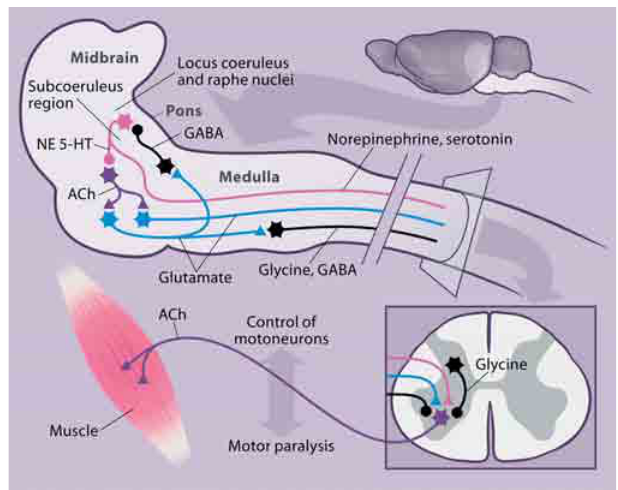
Figure 1. Model of Some of the Major Systems Involved in Regulating Muscle Activity in REM Sleep Drawn on a Sagittal Section of the Brainstem Cholinergic (ACh) neurons in the pons, which are under the inhibitory control of noradrenergic (NE) and serotonergic (5-HT) neurons, trigger REM sleep. They activate descending glutamatergic neurons, which in turn activate glycinergic